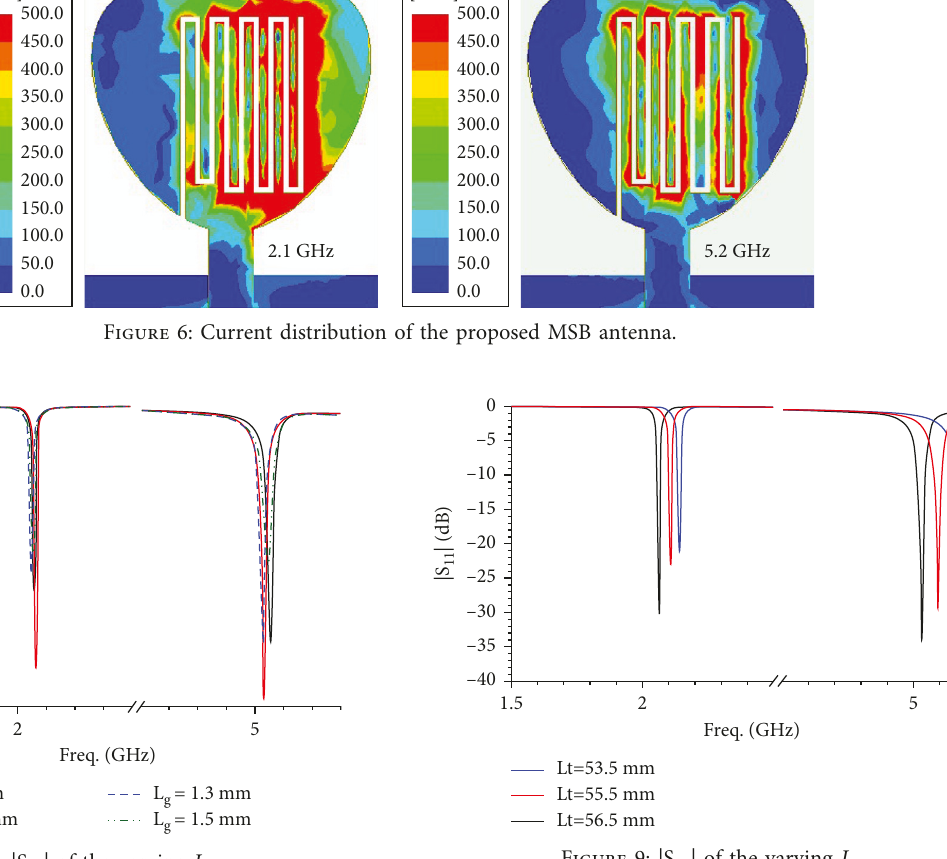
11 | of the varying